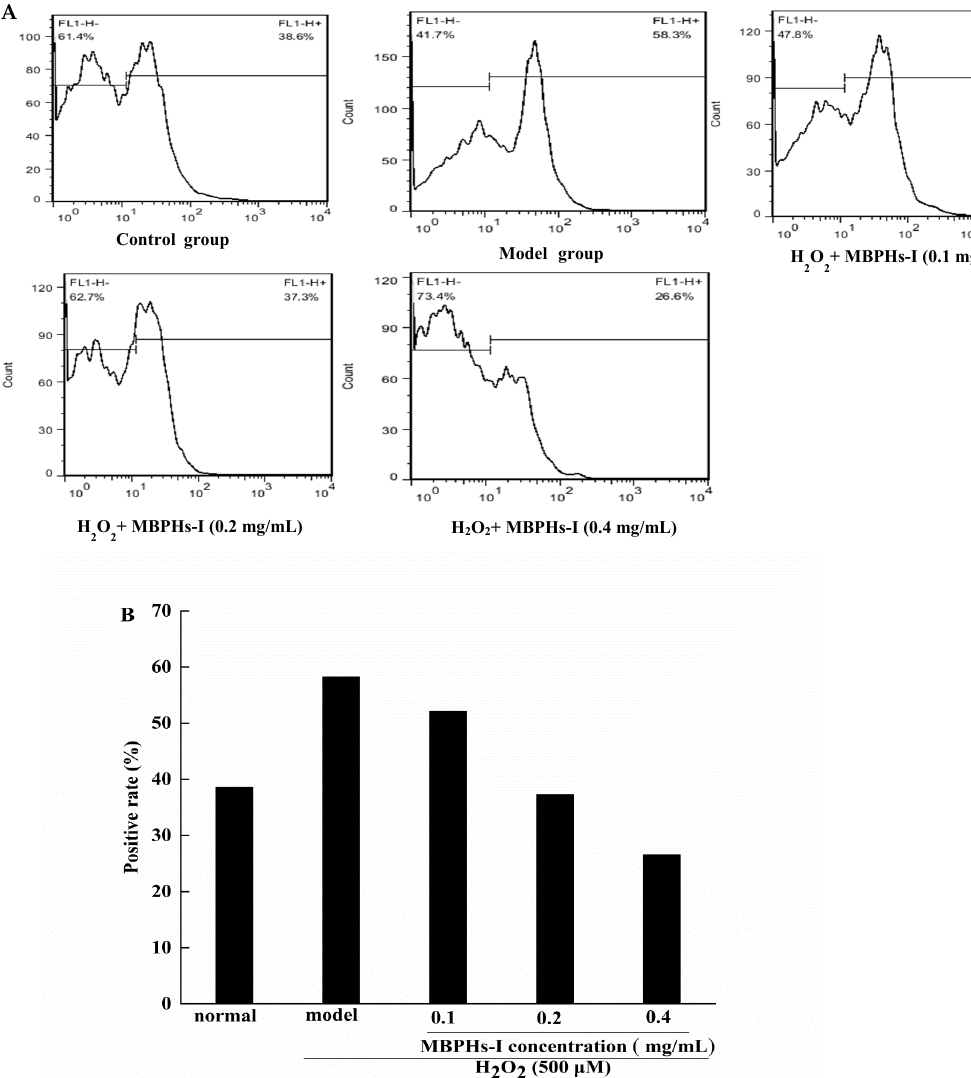
Figure 5. Flow cytometry showed that the positive control of the model group was 58.3% and there was a much higher difference than the control group (38.6%). However, pre-treatment with MBPHs-I effectively prevented ROS generation. With the increase of concentrations, the effects of inhibition were also constantly strengthened. When the concentration of MBPHs-I was 0.1, 0.2, 0.4 mg/mL, the positive cell rates were 52.2%, 37.3%, and 26.6%. This indicted that MBPHs-I could effectively protect NCTC-1469 cells from the damage of free radicals.